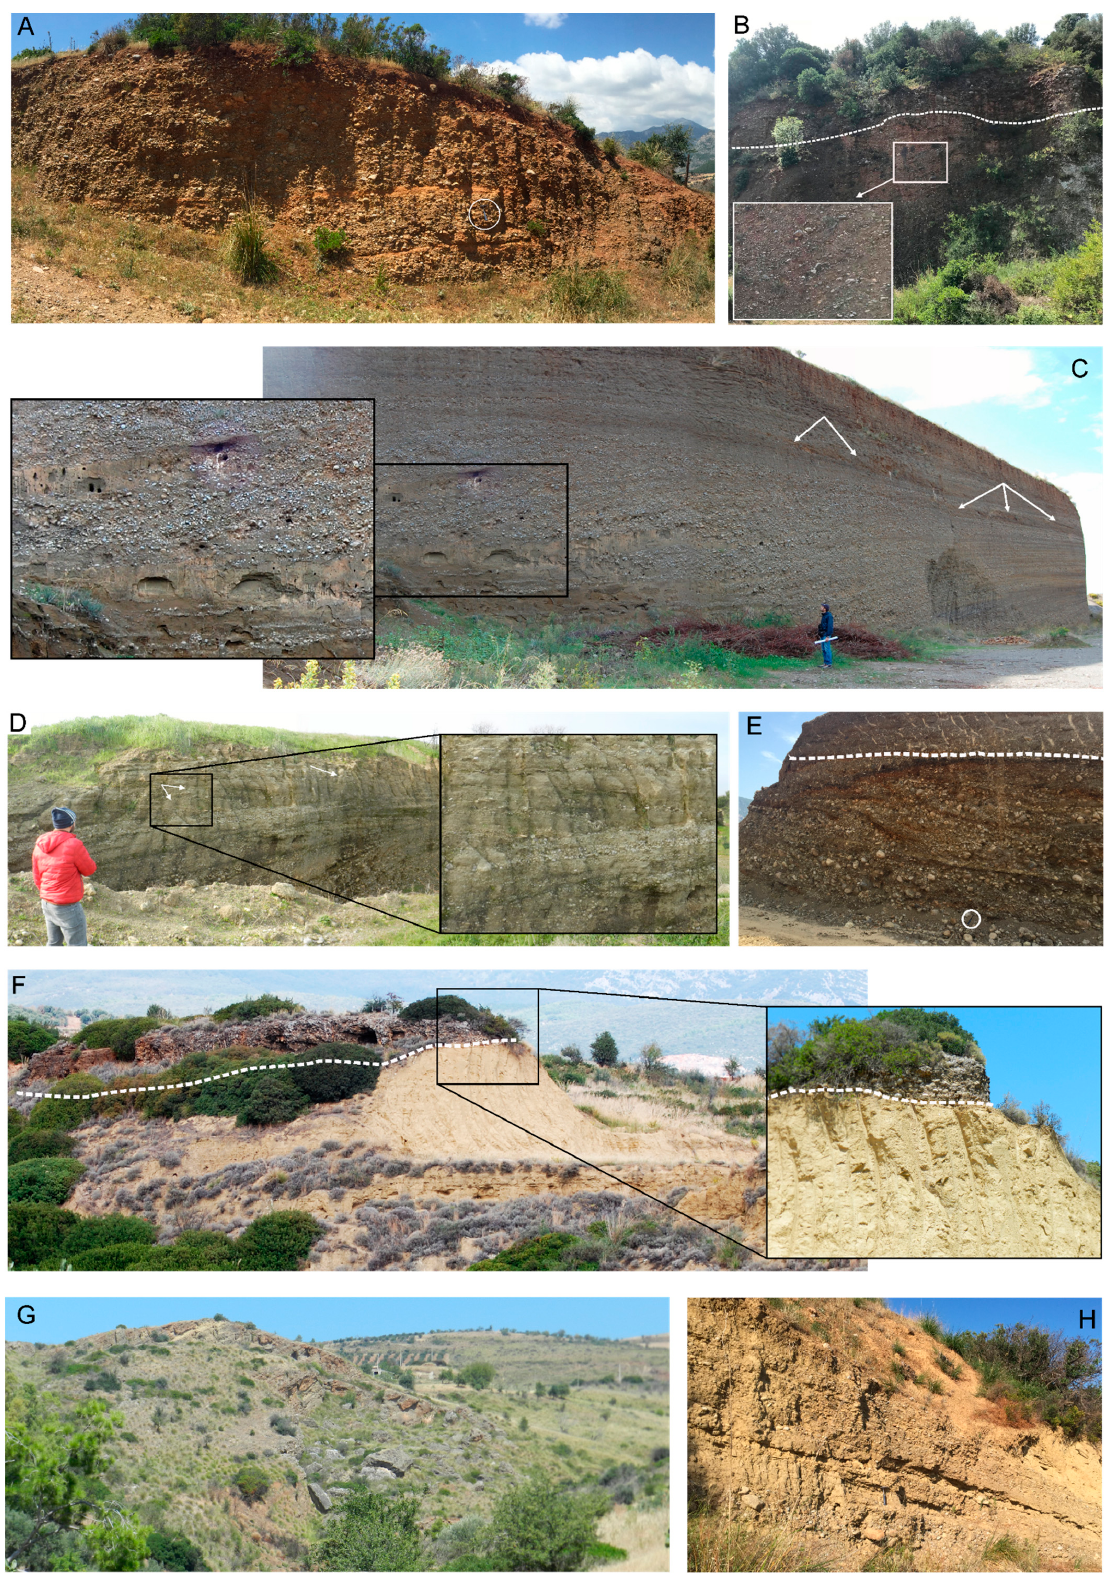
Figure 3. Overview of deposits and facies outcropping in the study area. ( A ) Clast-supported, sheet- like, and crudely stratified fluvial conglomerates (FA1; terrace T10). ( B ) Meter-thick topset unit resting erosively on the underlying foreset unit with oblique geometry (FA3b; terrace T6). ( C , D ) Sections